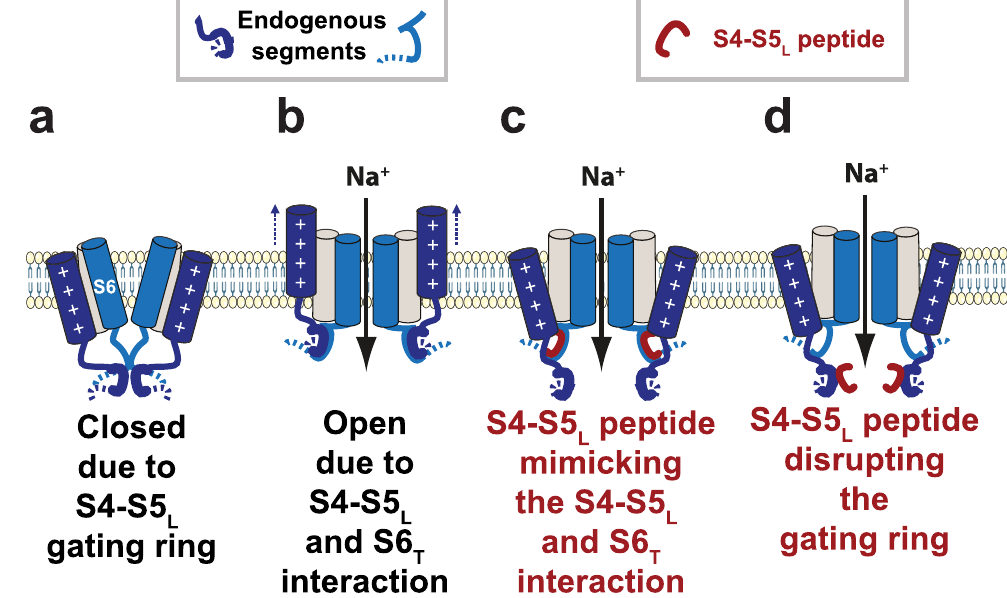
Figure 11. Summarizing schemes. ( a,b ) Two mechanisms of voltage-dependent gating. ( a ) The gating ring model in which the four S4-S5 L (endogenous segments, deep blue, only two are shown) constitute a constriction ring preventing S6 (endogenous segment, light blue) iris-like dilation. ( b ) Scheme of the ligand/receptor model in which S4-S5 L binds to S6 T to stabilize the channel in the open state. ( c) The S4-S5 L peptides (red) mimic the effect of endogenous S4-S5 L described in (b), stabilizing the open conformation. ( d ) Alternatively, the S4-S5 L peptides (red), interact with endogenous S4-S5 L , destabilizing the gating ring described in (a) and hence lead to channel